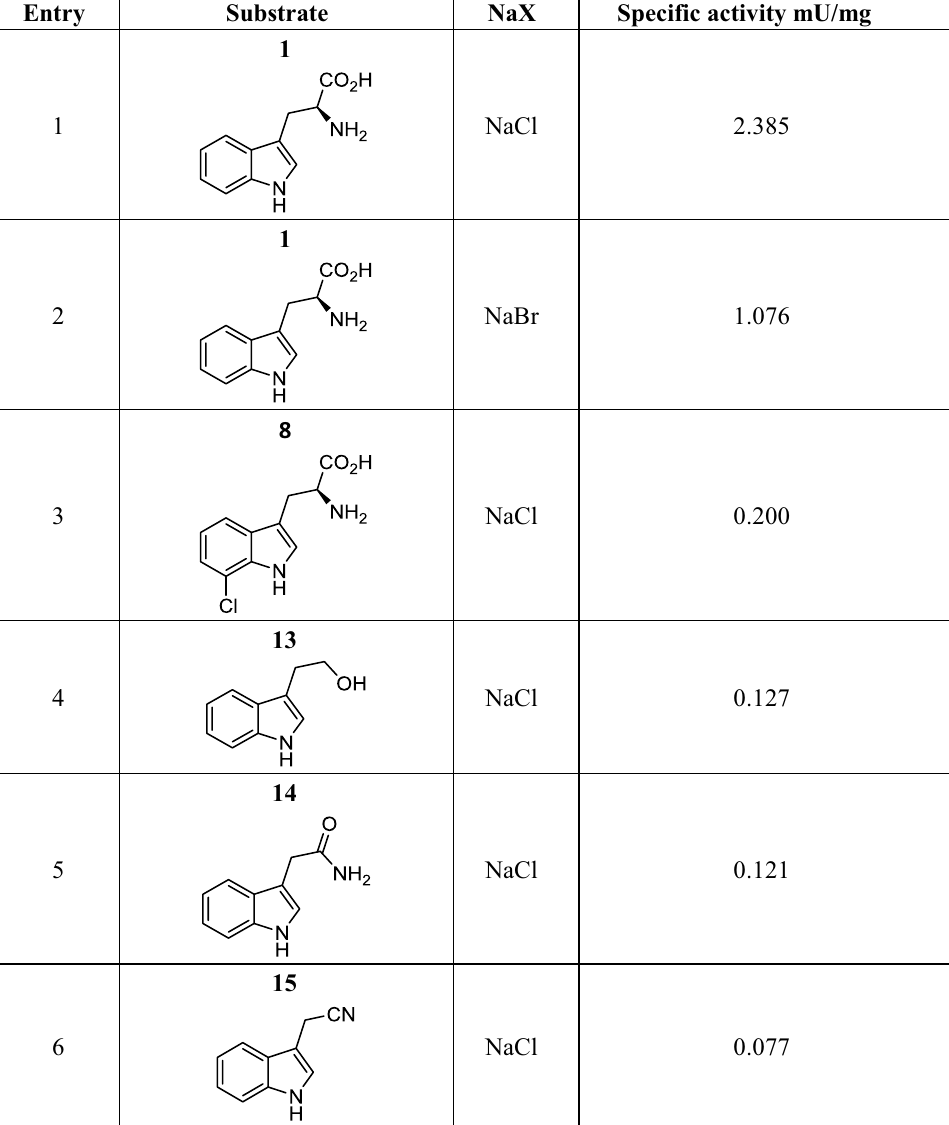
Table 2 Specific activities of Xszen FHal on various substrates